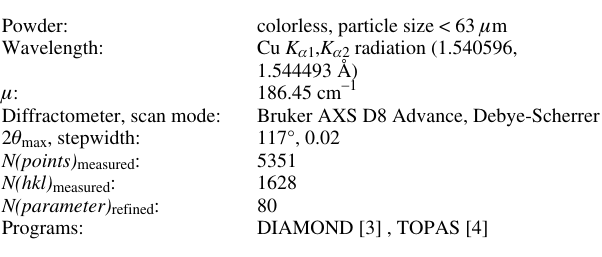
Table 1. Data collection and handling.